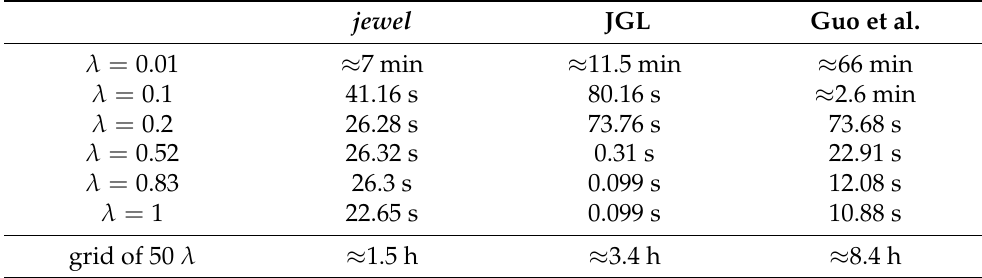
Table 1. Running time for different joint estimation methods: jewel , JGL [14], and Guo et al.’s proposal [13] for K = 3, p = 500, n k = 100, m = 1 and power = 1 over the uniform in log-scale grid of 50 parameters λ from 0.01 to 1. jewel JGL Guo et al. λ = 0.01 ≈ 7 min ≈ 11.5 min ≈ 66 min λ = 0.1 41.16